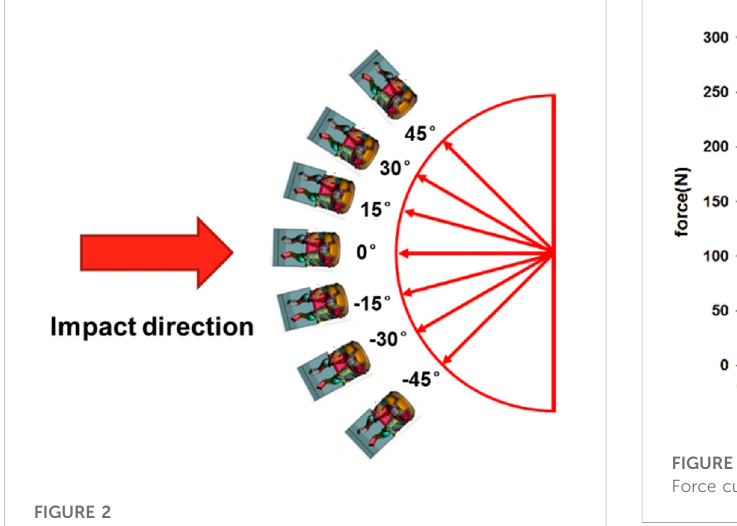
FIGURE 2 Seat rotation angle de fi nition.